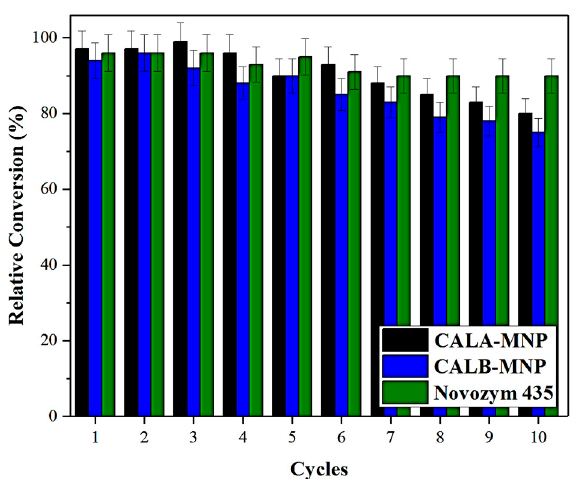
Figure 6. Operational Stability. Black column: CALA-MNP; blue column: CALB-MN; green column: Novozym® 435. Reaction medium: CALA-MNP: 10 mg of biocatalyst, 1:1, 6 h of incubation at 45 °C and 150× rpm ; CALB-MNP and Novozym ® 435: 12.5 mg of biocatalyst, 1:1, 6 h of incubation at 45 °C and 150× rpm . Further details are given in Section 3.